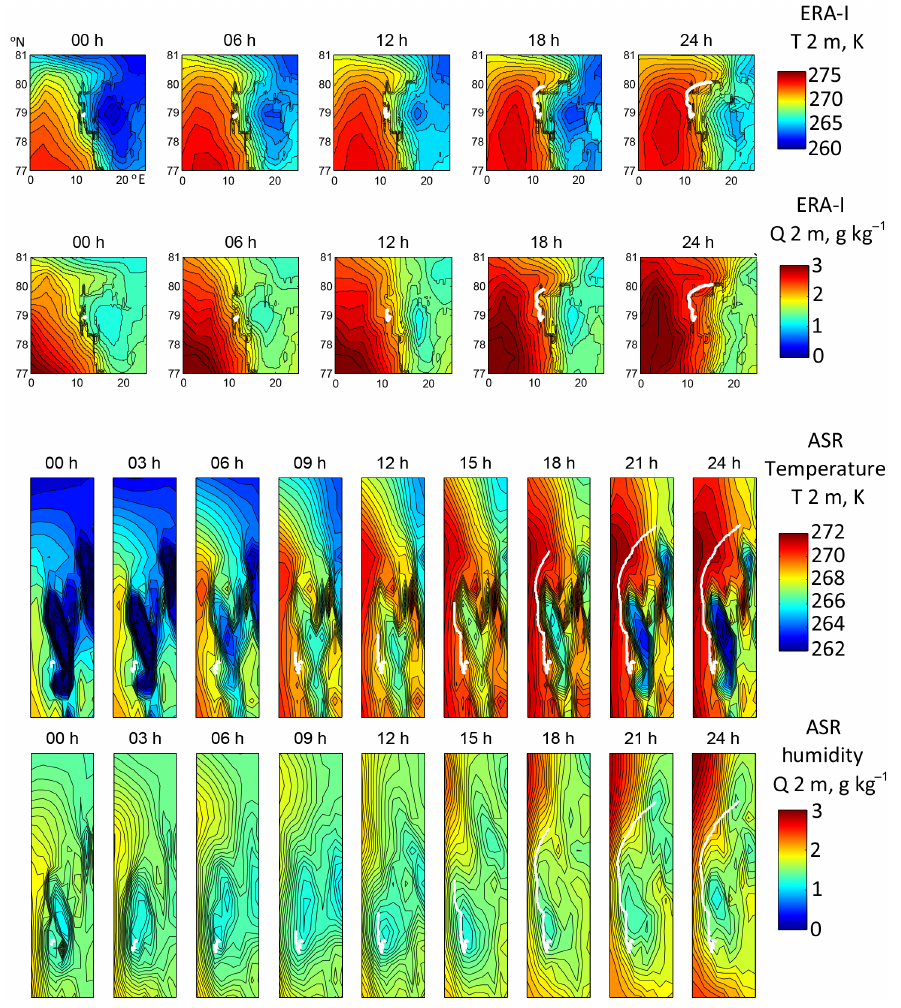
Figure 13. Surface 2m temperature and specific humidity over JD 131 according to ERA-I (upper) and ASR (lower). ERA-I outputs are shown on the regional scale at 6-hourly intervals whilst ASR outputs are shown on a local scale at 3-hourly intervals. The CMET flight 5 trajectory up to each time point is illustrated as a white